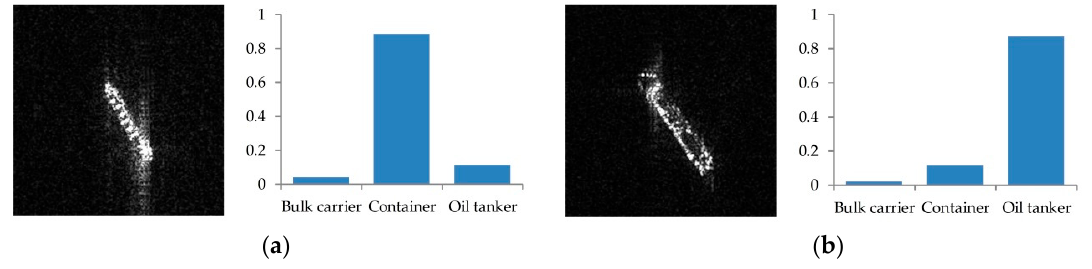
Figure 11. Examples of misclassified ships. ( a ) Bulk Carrier is classified as Container; ( b ) Container is misclassified as Oil Tanker. Their corresponding classification probabilities into three categories are also shown as indicated by royal blue histograms.